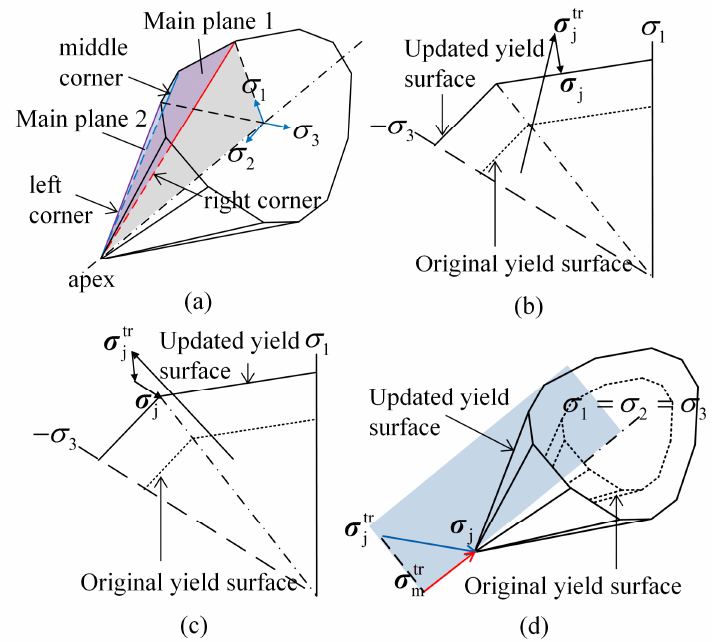
Figure A1. ( a ) Six different stress-update possibilities and the stress update schemes at ( b ) yield plane ( c ) corner and ( d ) apex.